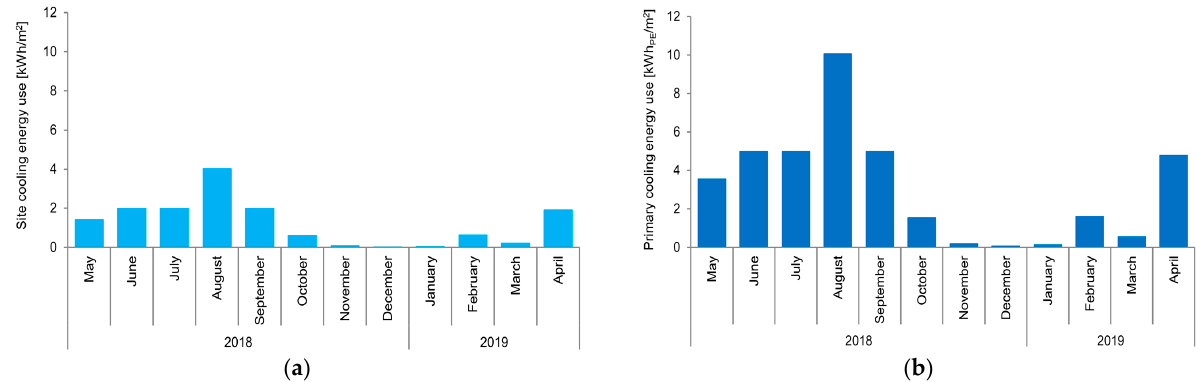
Figure 8. Total monthly electricity use from May 2018 to April 2019 for space cooling: ( a ) site cooling energy use (kWh/m 2 ); ( b ) primary cooling energy use (kWh PE /m 2 ).